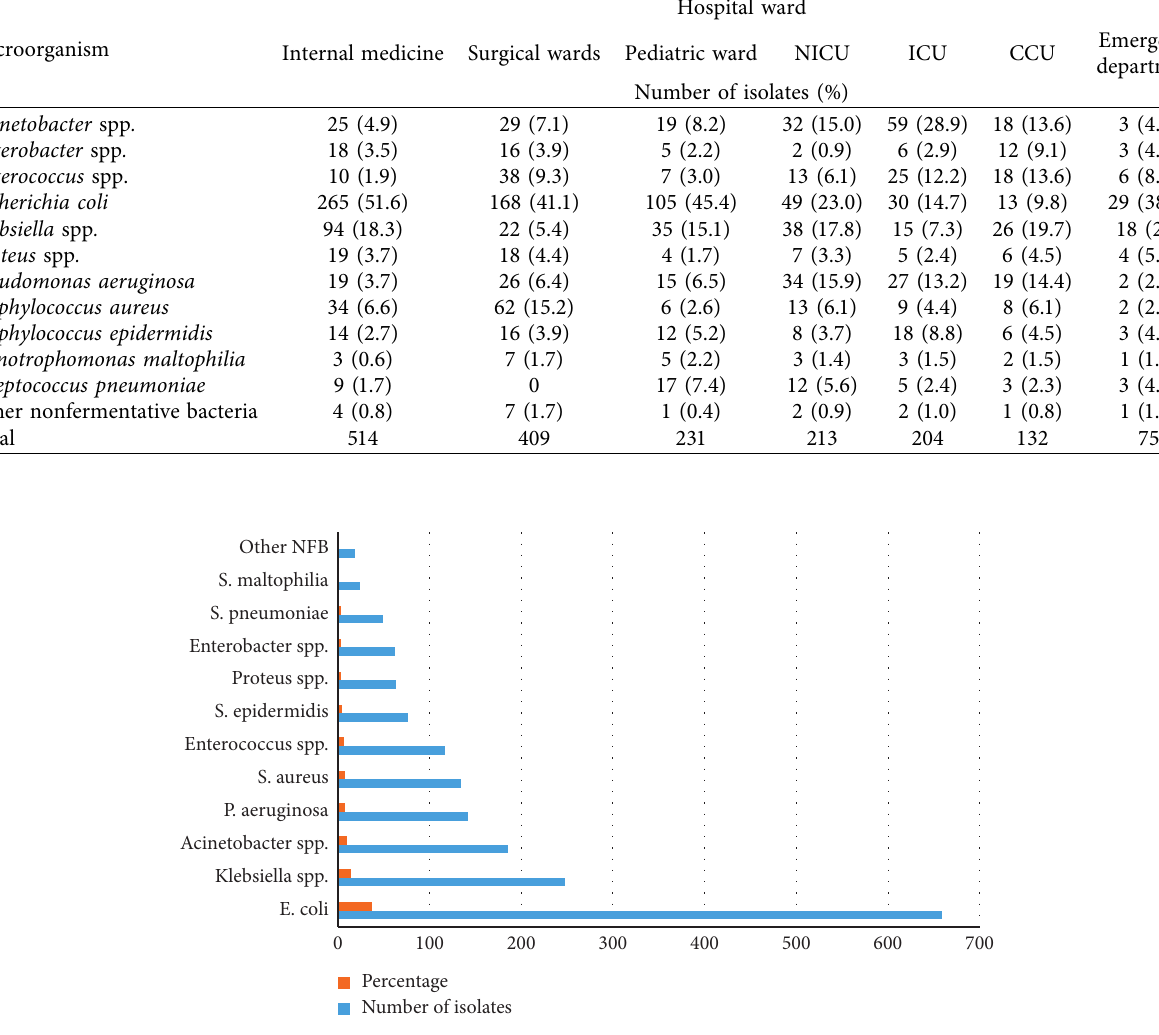
Stenotrophomonas maltophilia